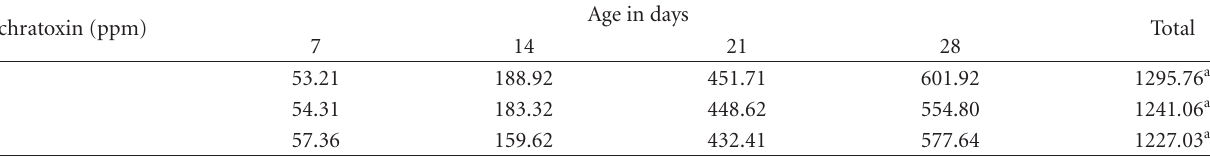
Table 2: Mean weekly feed consumption (g) of broiler chickens fed ochratoxin. Ochratoxin (ppm)